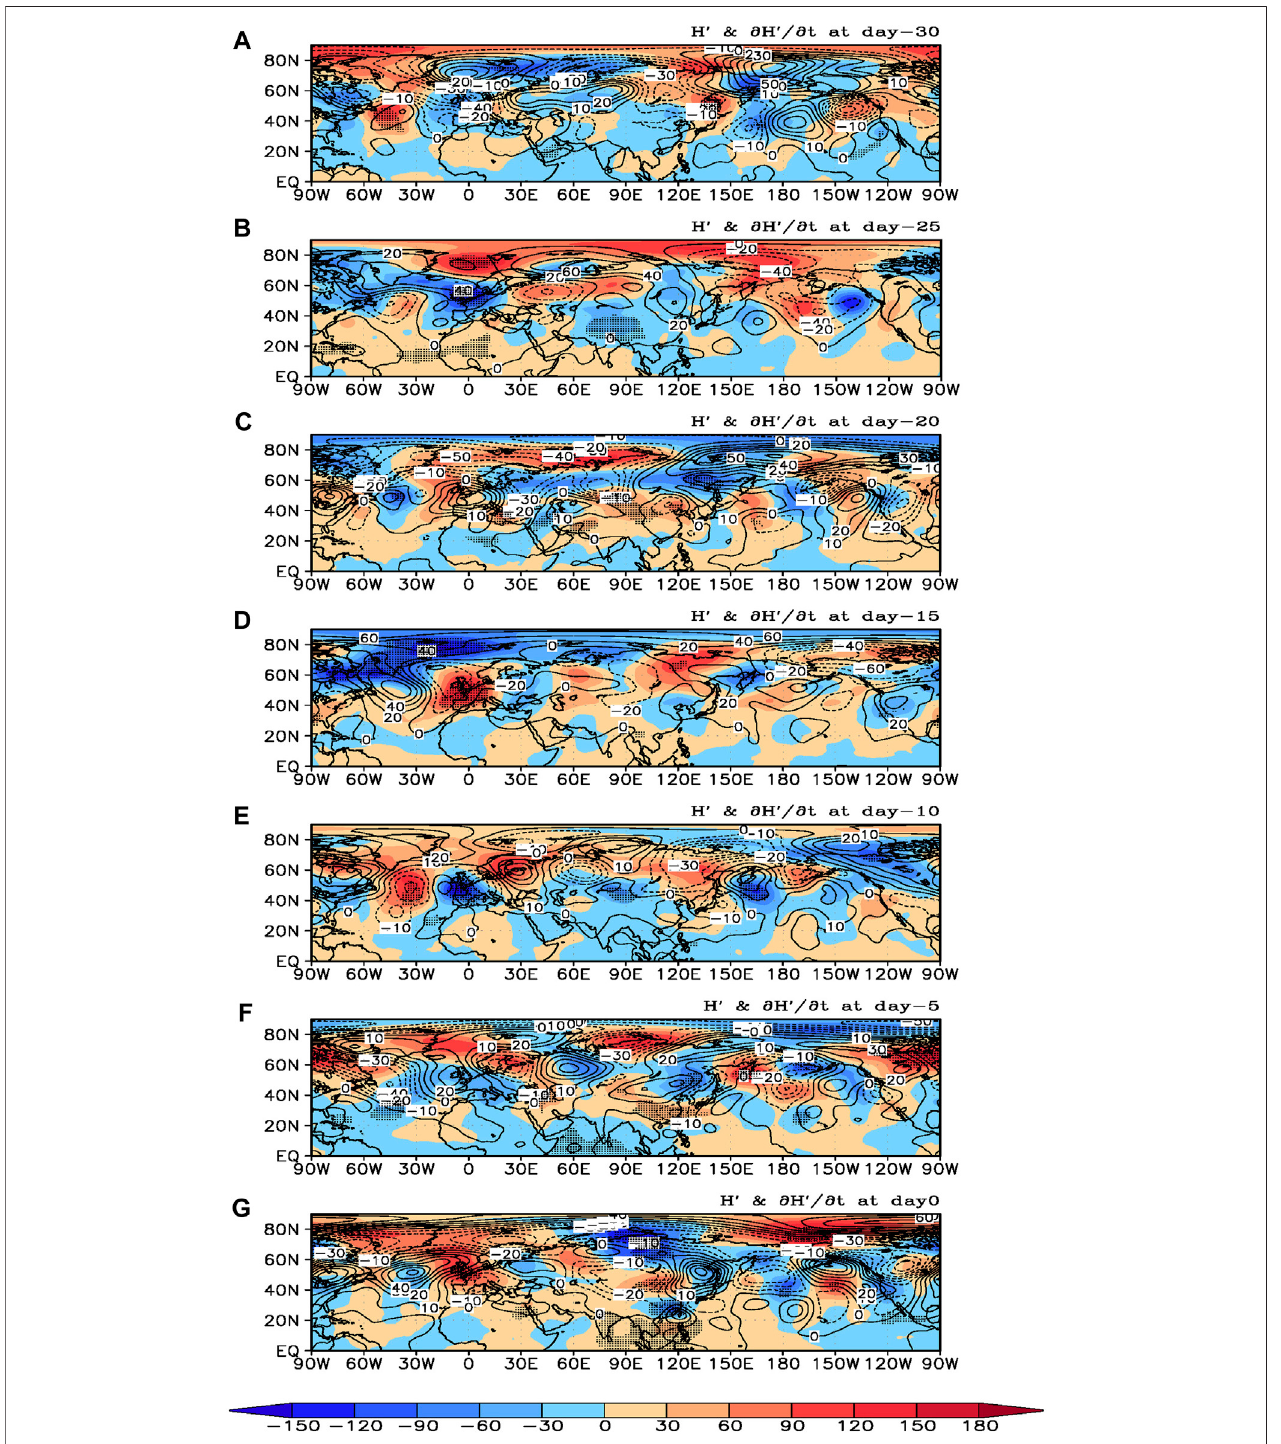
FIGURE 6 | Composite quasi-biweekly geopotential height (shaded, unit: gpm) and its tendency distribution at 500hPa (contoured, unit: gpm/d) in the northern hemisphere from day -30 to day 0, the dotted area indicates that it has passed the 95% con fi dence test. (A – G) represent day -30 to day 0, with 5-day interval.